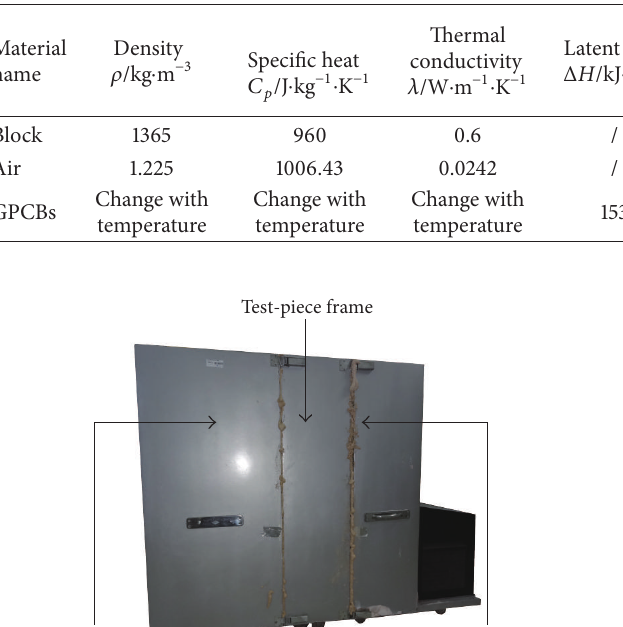
Table 2: The physical parameters of materials.